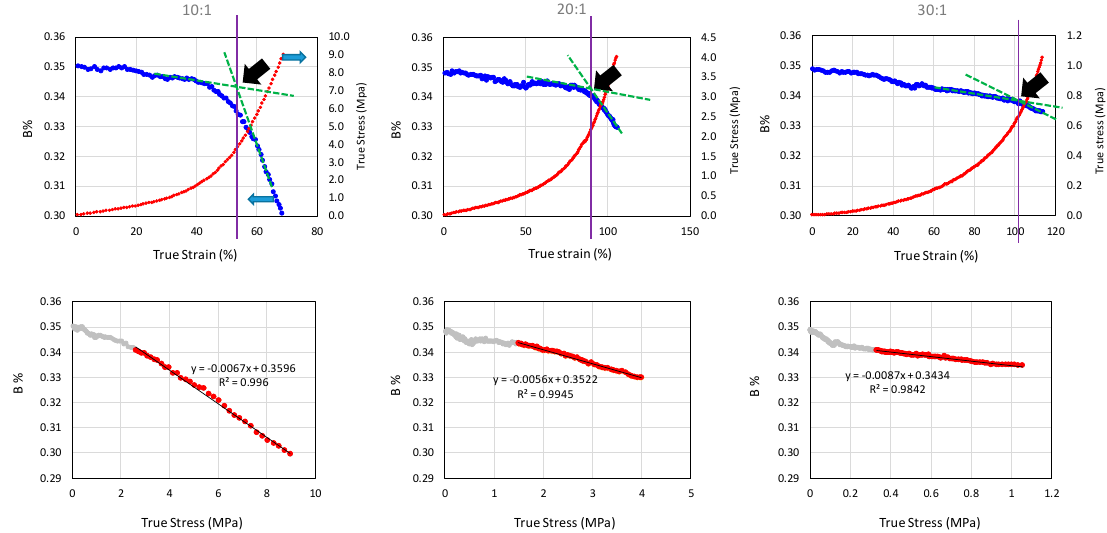
Figure 2. Effects of PDMS (poly(dimethyl siloxane)) mixing ratios on color change quasi-static tensile test. The top row shows blue color (B%) and true stress plotted against true strain and the dark arrows show the onset point for blue color change. The bottom row shows the B% plotted against true stress.